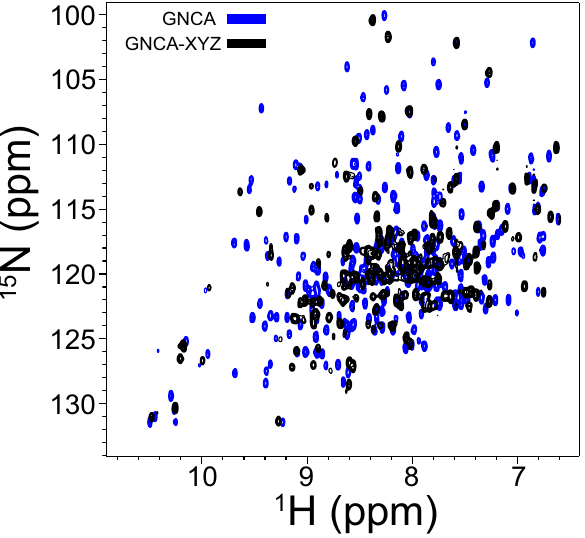
Fig. 6 HSQC NMR data indicate that GNCA-XYZ is more dynamic than GNCA β -lactamase. An overlay of GNCA-XYZ (black) and GNCA (blue) 15 N-HSQC spectra. Both proteins are well-structured as noted in the >3p.p.m. proton dispersion and consistent with the X-ray structures of a mixed α -helix and β -sheet structure. However, GNCA-XYZ shows spectral features consistent with increased protein dynamics. Speci fi cally, GNCA-XYZ shows fewer resonances, less peak resolution, and increased peak intensity heterogeneity; all are markers of increased protein dynamics relative to GNCA. Data were collected at 850MHz 1 H frequency and 30°C. The experimental data are provided as a Source Data fi lower peak resolution and increased peak intensity heterogeneity, which is consistent with it having increased backbone dynamics over the relatively rigid GNCA protein. Taken together, the NMR data